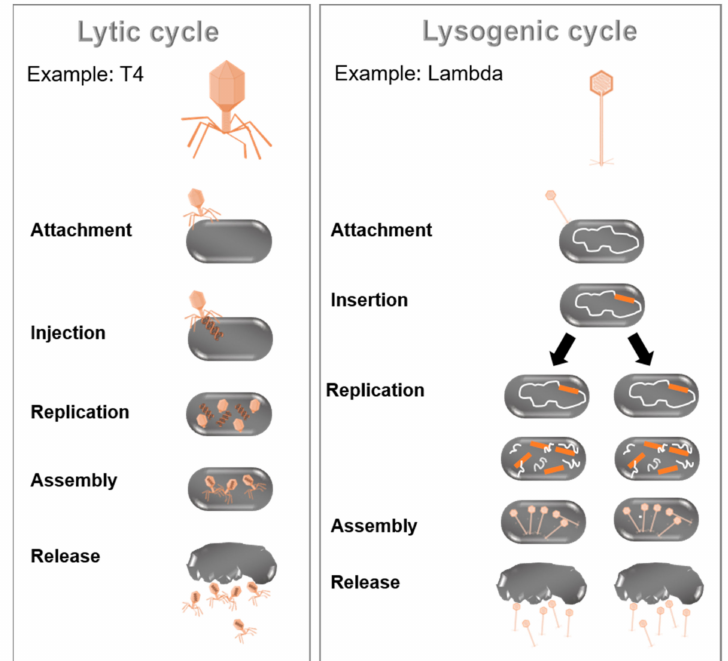
Figure 3. Phage proliferation. ( Left ) Infection by lytic phages like E. coli phage T4 leads to the multiplication of virus and subsequent lysis of bacterial host cell. ( Right ) In lysogenic cycle, phage genome (e.g., of E. coli phage Lambda) is integrated into bacterial chromosome, and an inactive prophage is replicated as part of host chromosome. Environmental triggers cause excision of phage genome and entry into lytic